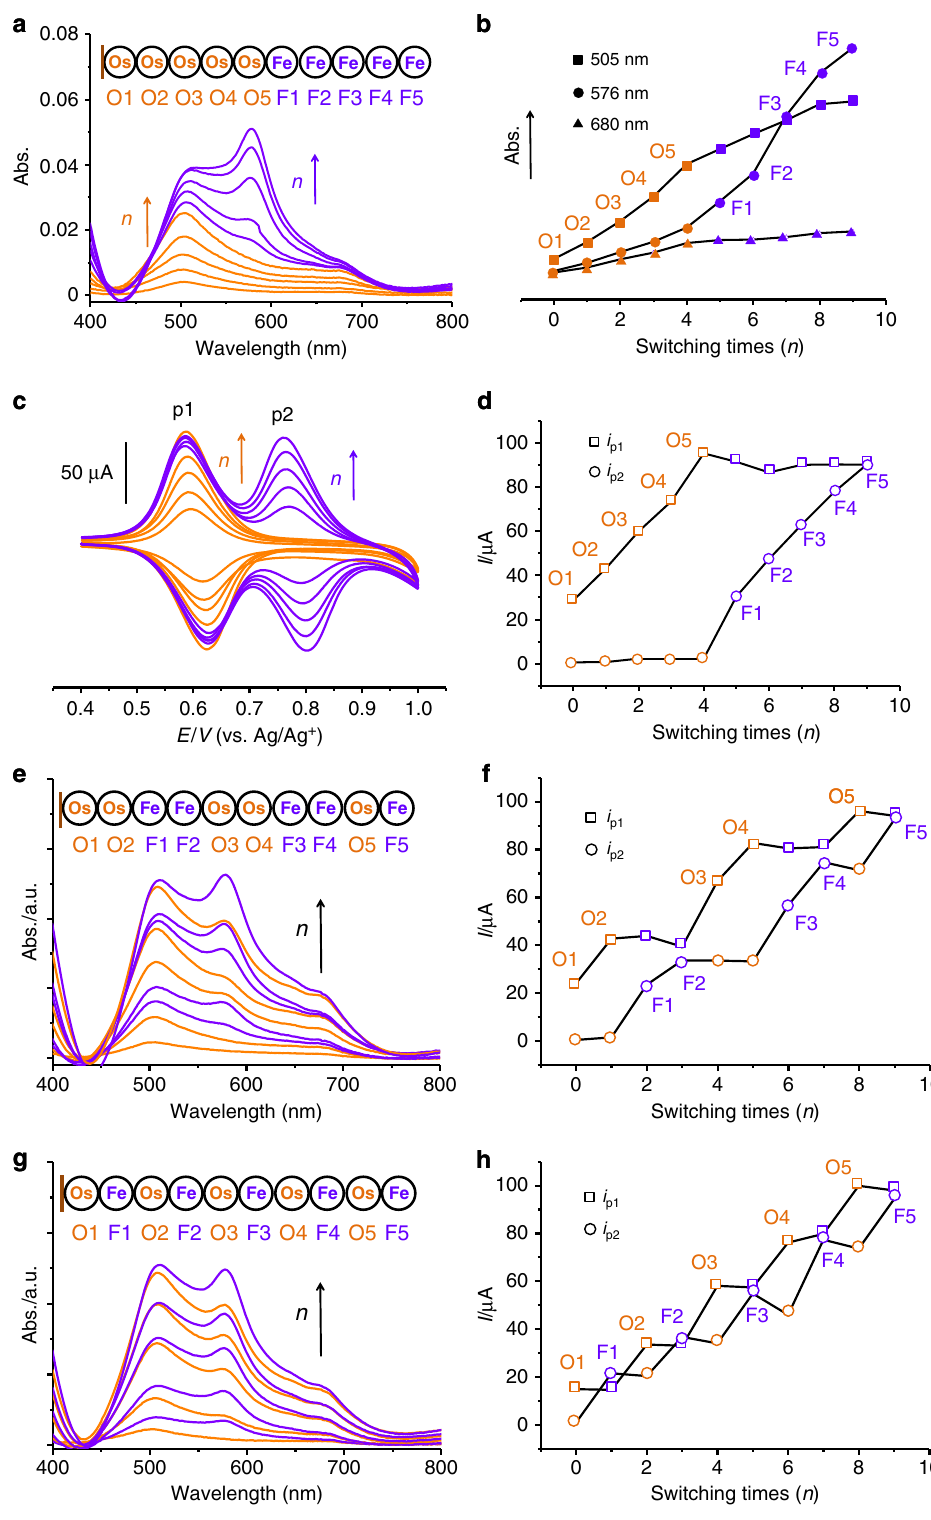
Fig. 3 Electrosynthesis of binary organometallic polymers. a , b Illustrations of UV – vis absorbance and intensities as a function of switching times during iterative synthesis. c , d Illustrations of current intensities of oxidative peaks as a function of switching times during iterative synthesis. e – h Illustrations of UV – vis absorbances and current intensities of oxidative peaks as a function of switching times during iterative of organometallic polymers with different